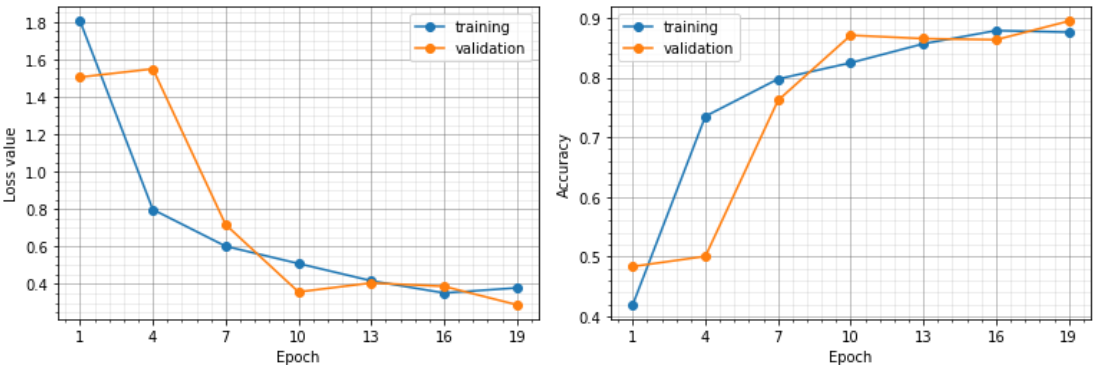
Figure 8. Training and validation set (left) loss function value, (right) overall accuracy.